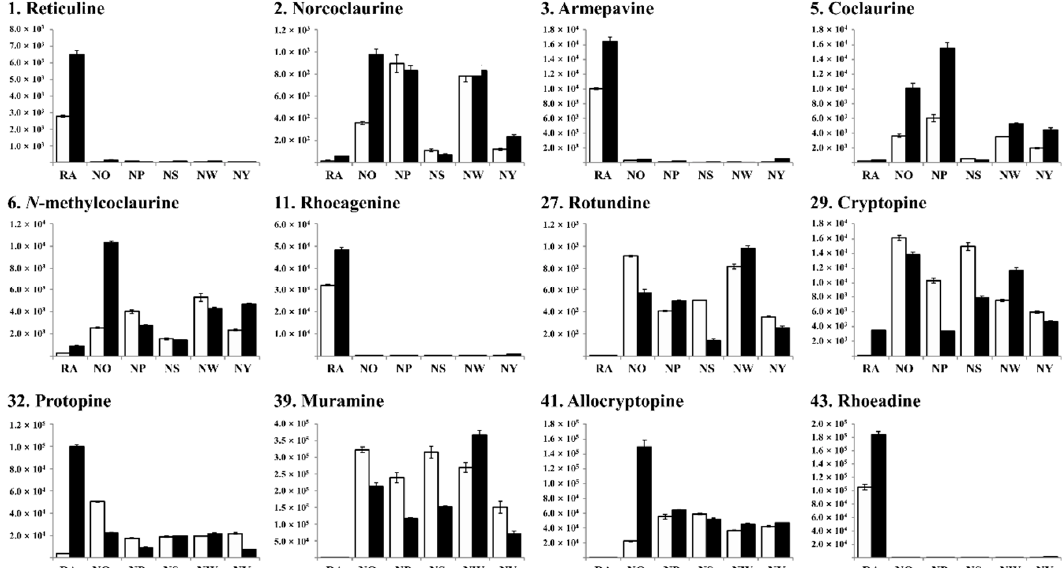
Figure 3. The abundance of the identified alkaloids in P. nudicaule and P. rhoeas , as determined by liquid chromatography high-resolution mass spectrometry (LC-HRMS). Bars with white and black colors represent specimens of 2017 and 2018, respectively. Reticuline ( 1 ), demethylcoclaurine ( 2 ), armepavine ( 3 ), coclaurine ( 5 ), N -methylcoclaurine ( 6 ), rhoeagenine ( 11 ), rotundine ( 27 ), cryptopine ( 29 ), protopine ( 32 ), muramine ( 39 ), allocryptopine ( 41 ), and rhoeadine ( 43 ).